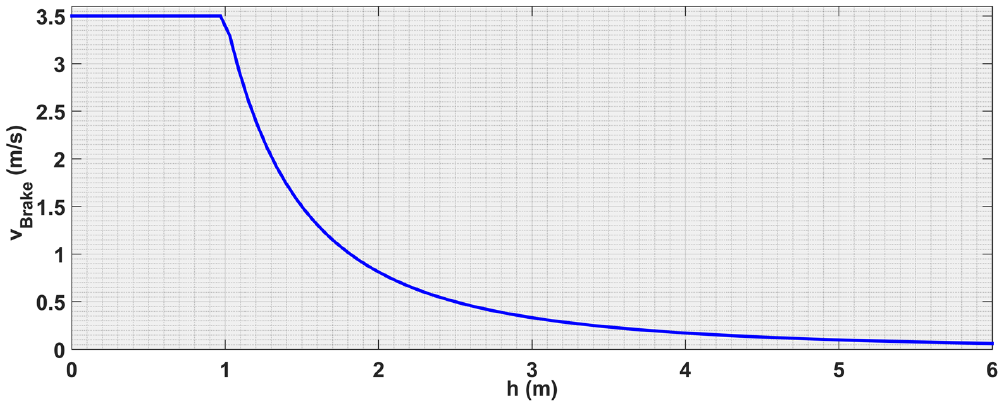
Figure 9. Repulsion curve for v i = 1.5 m/s and h desired = 1.5